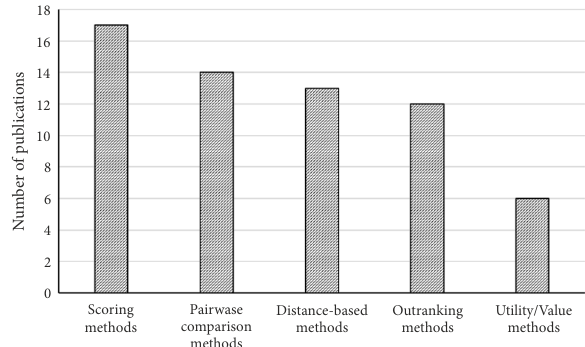
Figure 8. MCDM methods used in sustainable design of bridges by